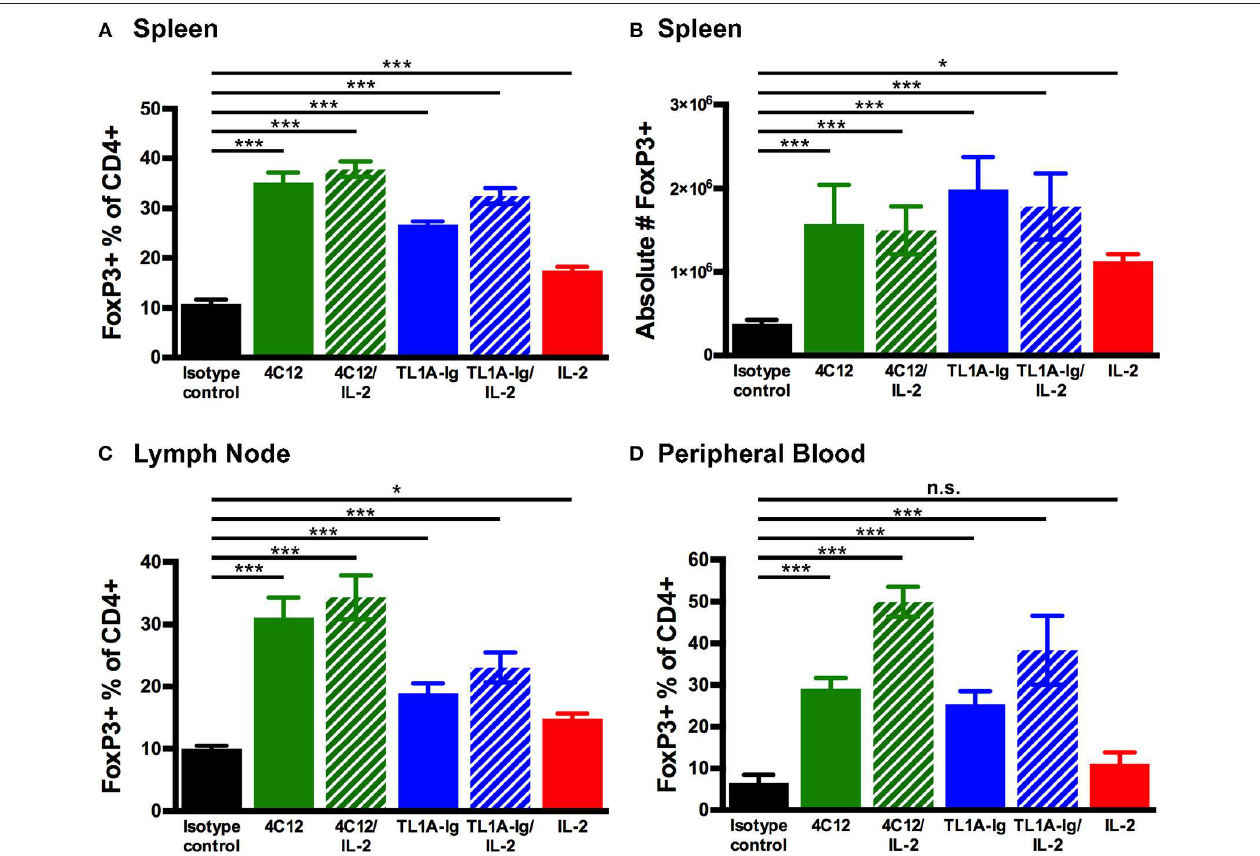
FIGURE 1 | Regulatory T cells are expanded through in vivo activation of the death receptor 3 pathway with agonistic antibody (4C12) or fusion protein incorporating the endogenous ligand (TL1A-Ig) with or without IL-2. Mice were treated as in Materials and Methods. Tissues were harvested on day 7 of the treatment regimen, processed and stained, and analyzed by flow cytometry. Live cells were gated on the lymphocyte population, followed by CD3 + CD19 − , CD4 + and FoxP3 + . Shown are the percent FoxP3 + of CD4 + cells in (A) splenocytes, (C) lymphocytes, and (D) peripheral blood. Also shown are the (B) absolute number of regulatory T cells in splenocytes. (Shown are the mean and SD for each group ( n = 4). n.s., not significant; * p < 0.05 and *** p < 0.001 as compared to isotype control antibody treatment, one-way ANOVA with Bonferroni correction for multiple comparisons). Data shown are representative of 2 independent experiments.